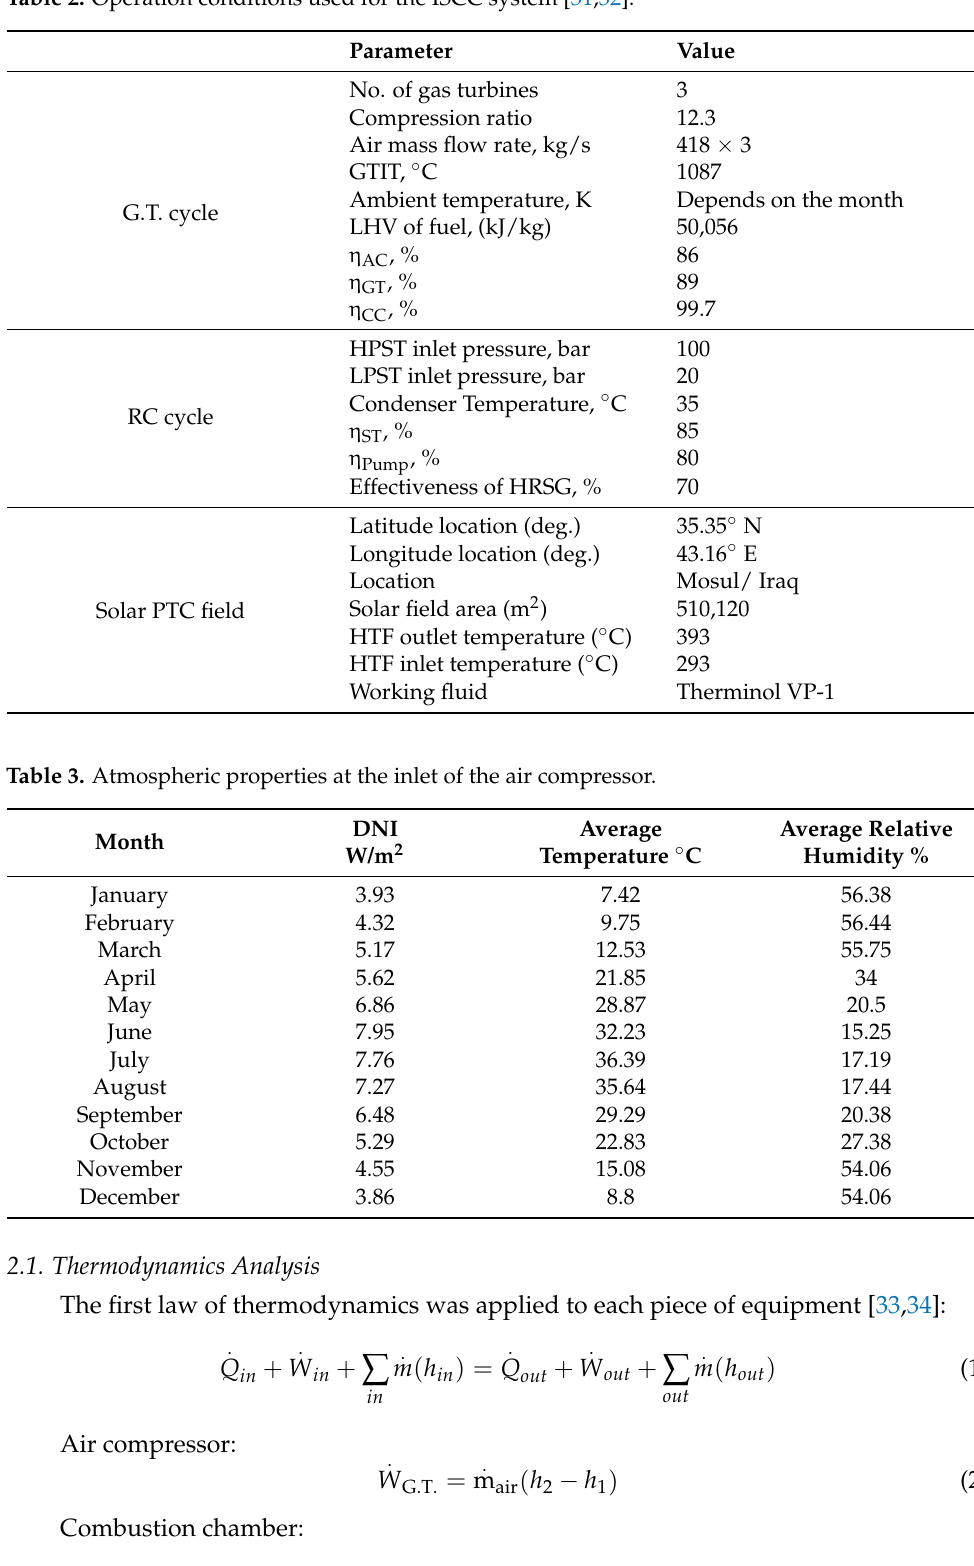
Table 2. Operation conditions used for the ISCC system [31,32].